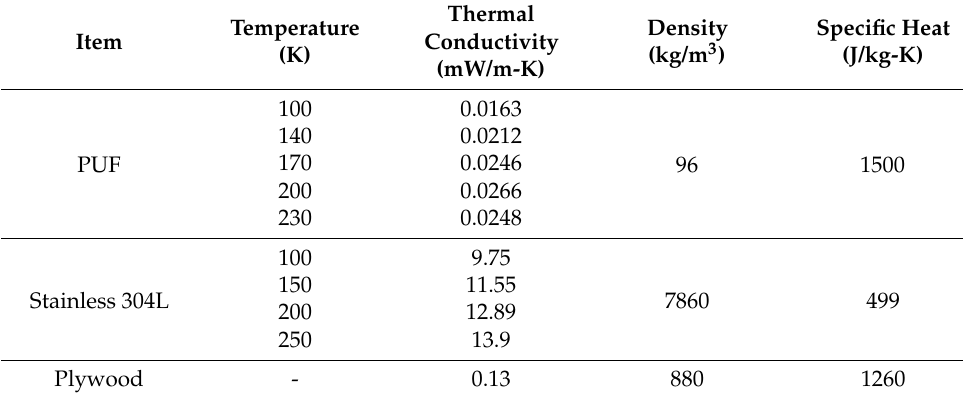
Table 3. Material property for thermal analysis.